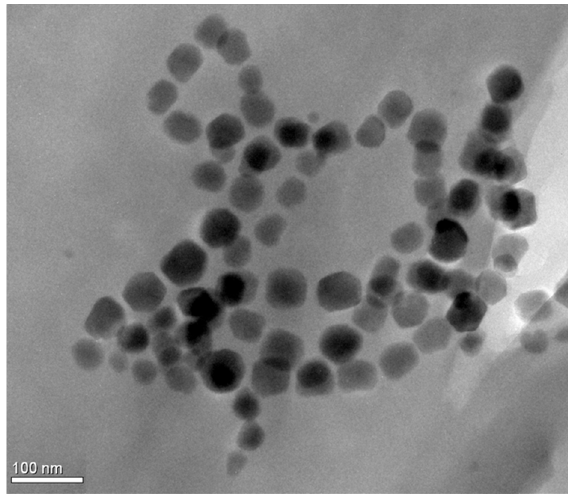
Figure 1. TEM image of isolated magnetosomes.